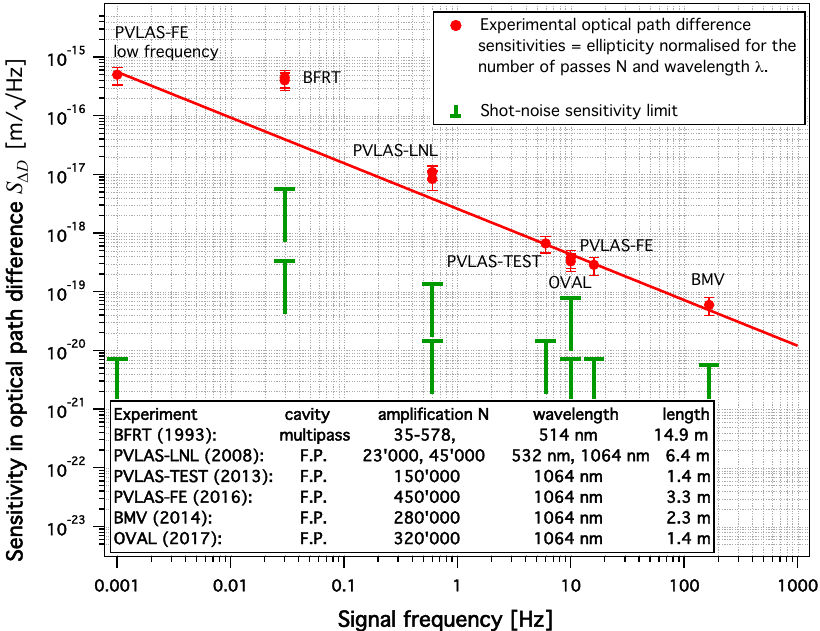
Figure 7. Measured optical path difference noise densities S ∆ D in polarimeters set up to measure VMB plotted as a function of their signal frequency. Data were taken from the experiments BFRT [40], PVLAS-LNL [44,45], PVLAS-Test [61], PVLAS-FE [59], BMV [62] and OVAL [63]. The error bars are an estimated